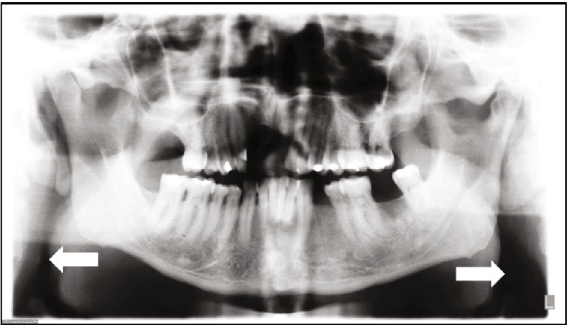
Figure 4: Panoramic radiograph showing the presence of bilateral radiopaque masses